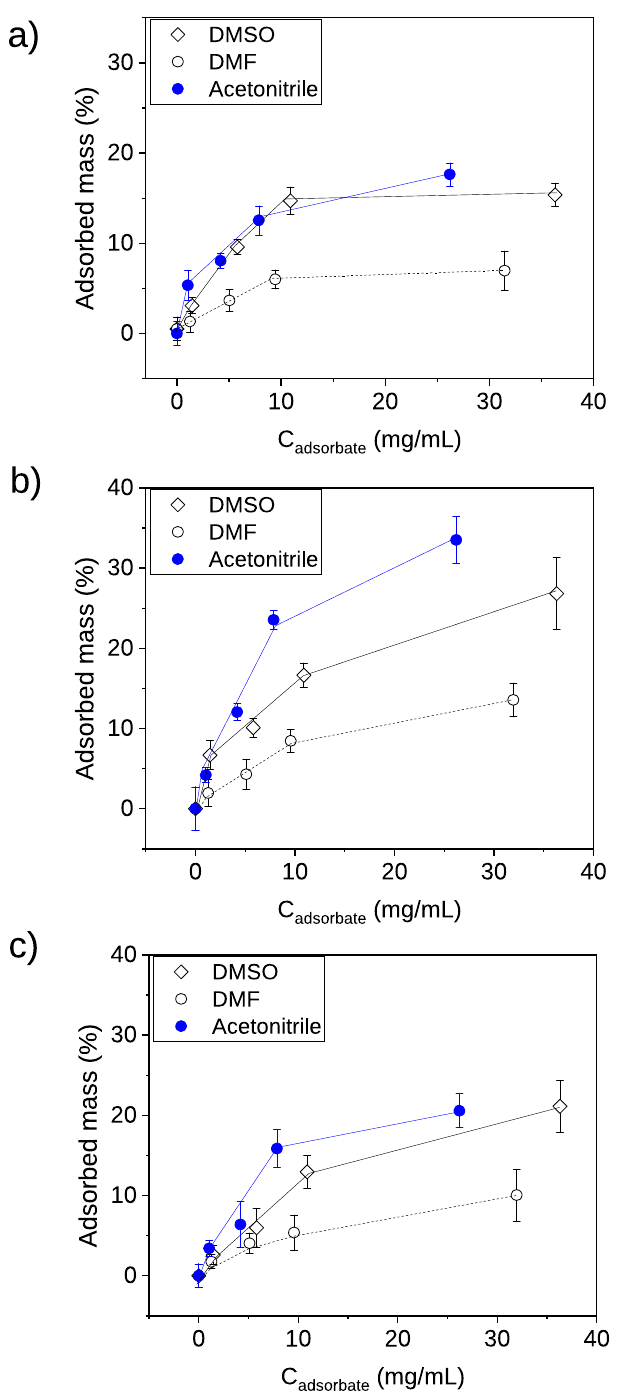
Fig. 8 Adsorption isotherm curves determined by magnetic sutentation experiments. Adsorption isotherm curves for: a MIL-88A(Fe), b MOF- 74(Cu) and c MOF-74(Co) measured by magnetic sustentation experiments. Each measurement was repeated fi ve times in order to provide the corresponding associated statistical